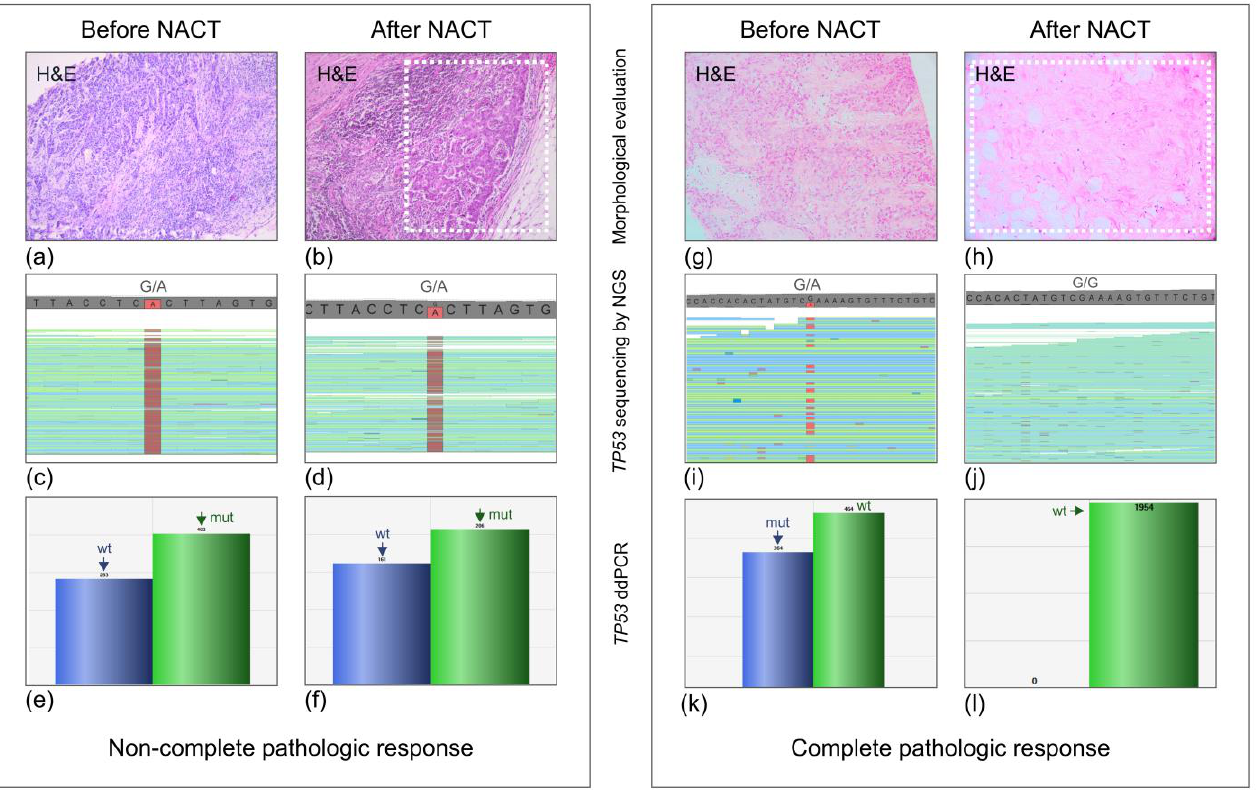
Figure 1. Examples of cases with non-complete (Miller–Payne score 3) and complete (Miller–Payne score 5) pathological response. Morphological and molecular data are presented. Upper panel: hematoxylin–eosin staining of primary ( a , g ) and residual tumors ( b , h ); middle panel: next-generation sequencing (NGS) reads ( c , d , i , j ); bottom panel: digital droplet PCR (ddPCR) droplets positive for FAM (blue) or R6G (green) ( e , f , k , l ).